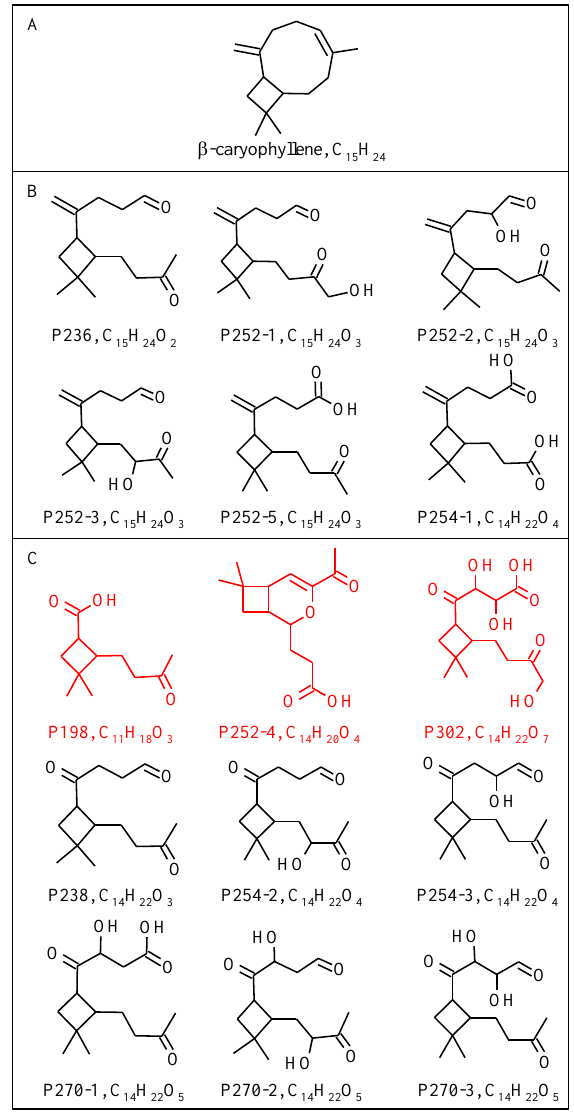
Fig. 1. Molecular structures of (A) β -caryophyllene, (B) detected first-generation ozonolysis products, and (C) detected second- generation ozonolysis products. The fifteen structures represented in panels B and C are found in the particles after ozonolysis. Three of them (viz. P198, P252-4, and P302) are reported herein for the first time and are highlighted in red. Label “Pxxx” represents a product P having a nominal mass of xxx . Labels “Pxxx-1”, “Pxxx- 2”, and “Pxxx-3” denote distinct molecules (i.e., of different chro- matographic retention times) that have the same nominal